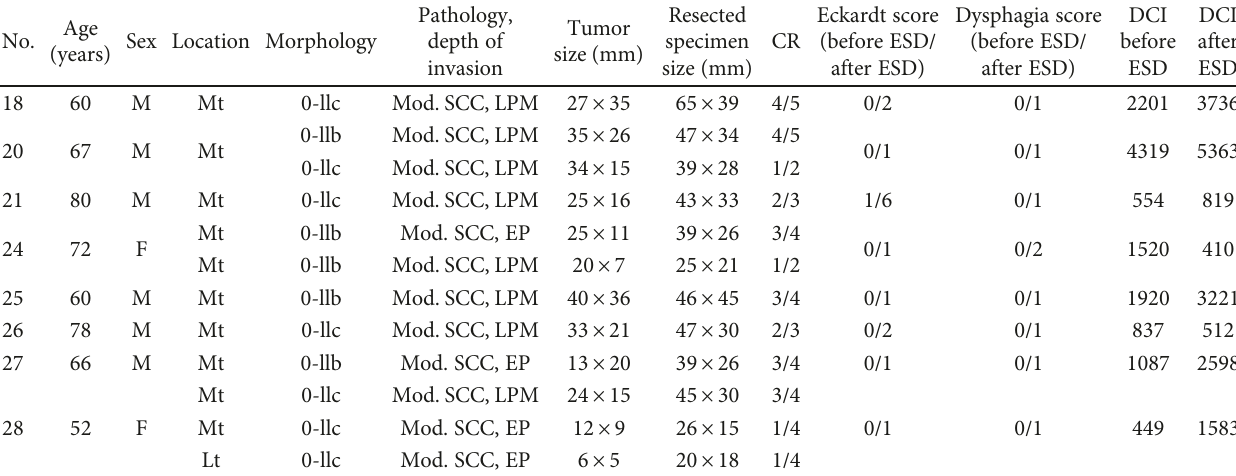
Table 5: Review of patients with increases in symptom scores after endoscopic submucosal dissection. Age No. Sex Location (years)